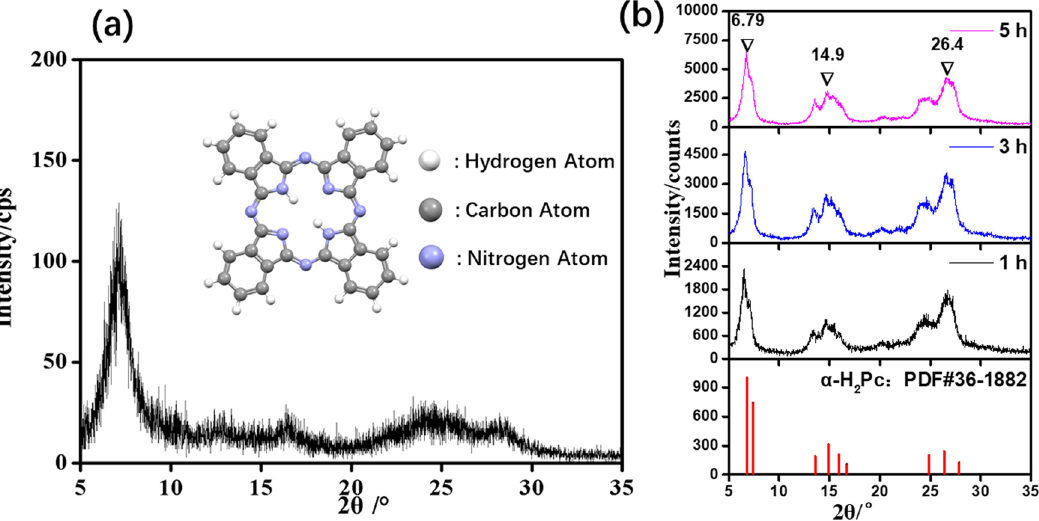
Figure 1: ( a ) XRD pattern of the puri fi ed H 2 Pc, the inset picture is a ball – stick model of H 2 Pc molecule; ( b ) XRD patterns of the H 2 Pc obtained from di ff erent dry ball - milling